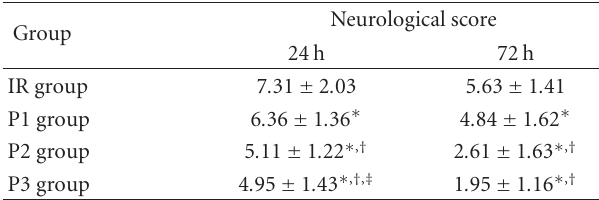
Table 1: Neurologic score after 24 and 72h of ischemia after middle cerebral artery occlusion.